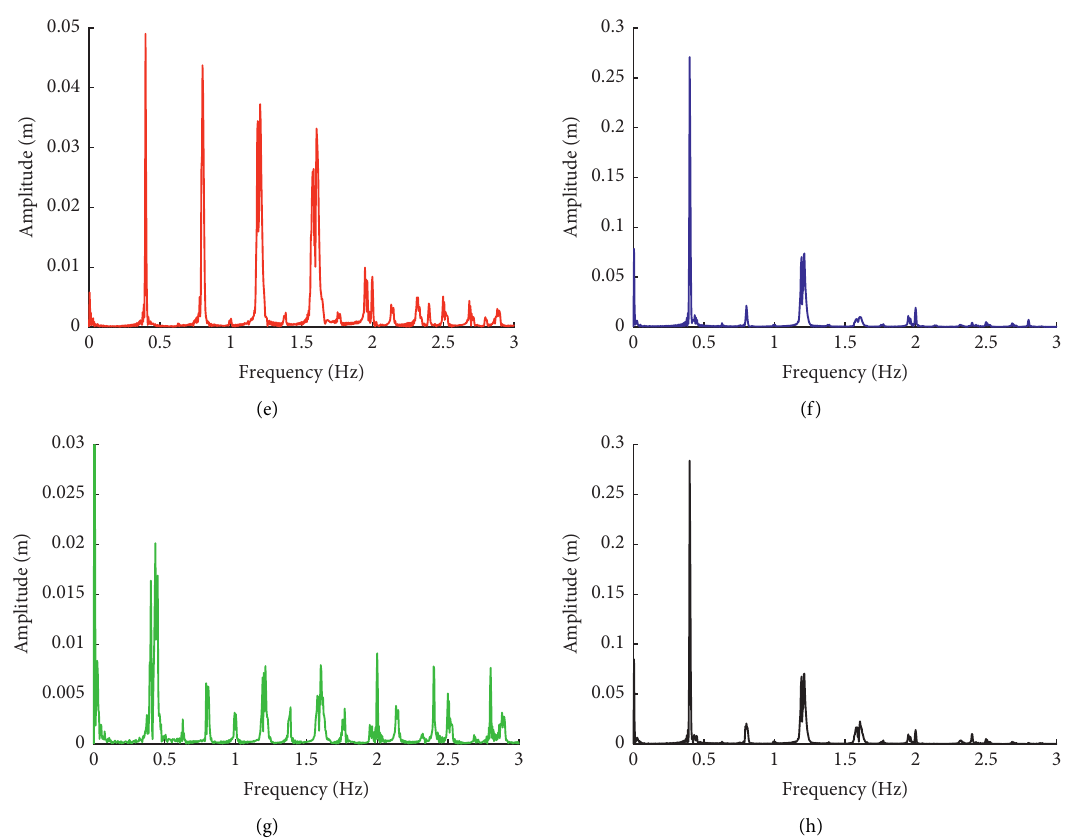
Figure 2: Finite element simulation results under excitation at fixed intervals. (a) Vertical displacement at the excitation point. (b) Vertical displacement at 1/4 point of the line. (c) Vertical displacement at midpoint of the line. (d) Vertical displacement at 3/4 point of the line. (e) The amplitude spectrum at the excitation point. (f) The amplitude spectrum at 1/4 point of the line. (g) The amplitude spectrum at midpoint of the line. (h) The amplitude spectrum at 3/4 point of the line.